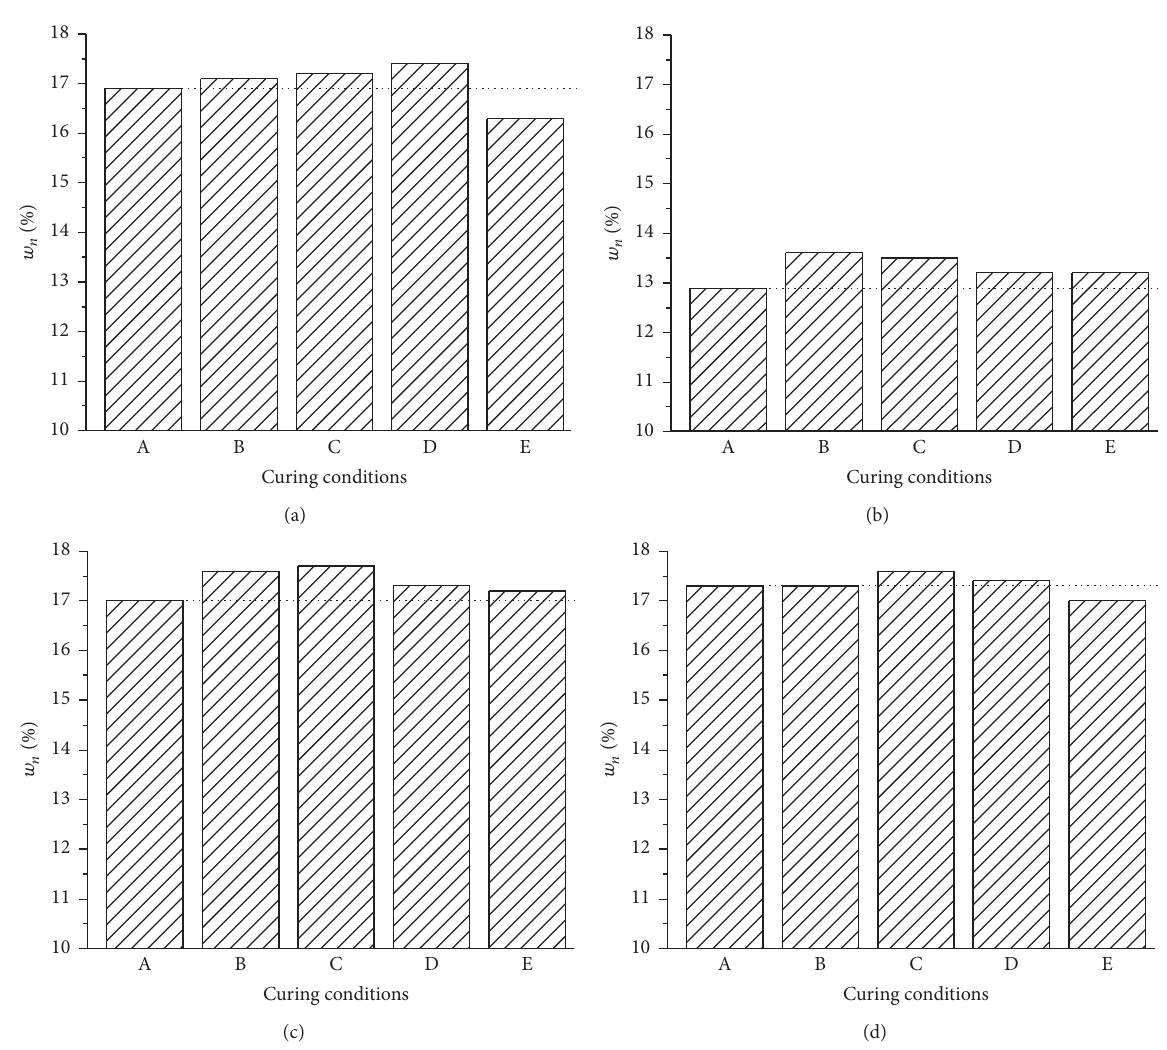
Figure 2: The 90 d nonevaporable water content of pastes under different curing conditions. Samples: (a) plain cement, (b) 45% FA, (c) 45% GGBS, and (d) 12%